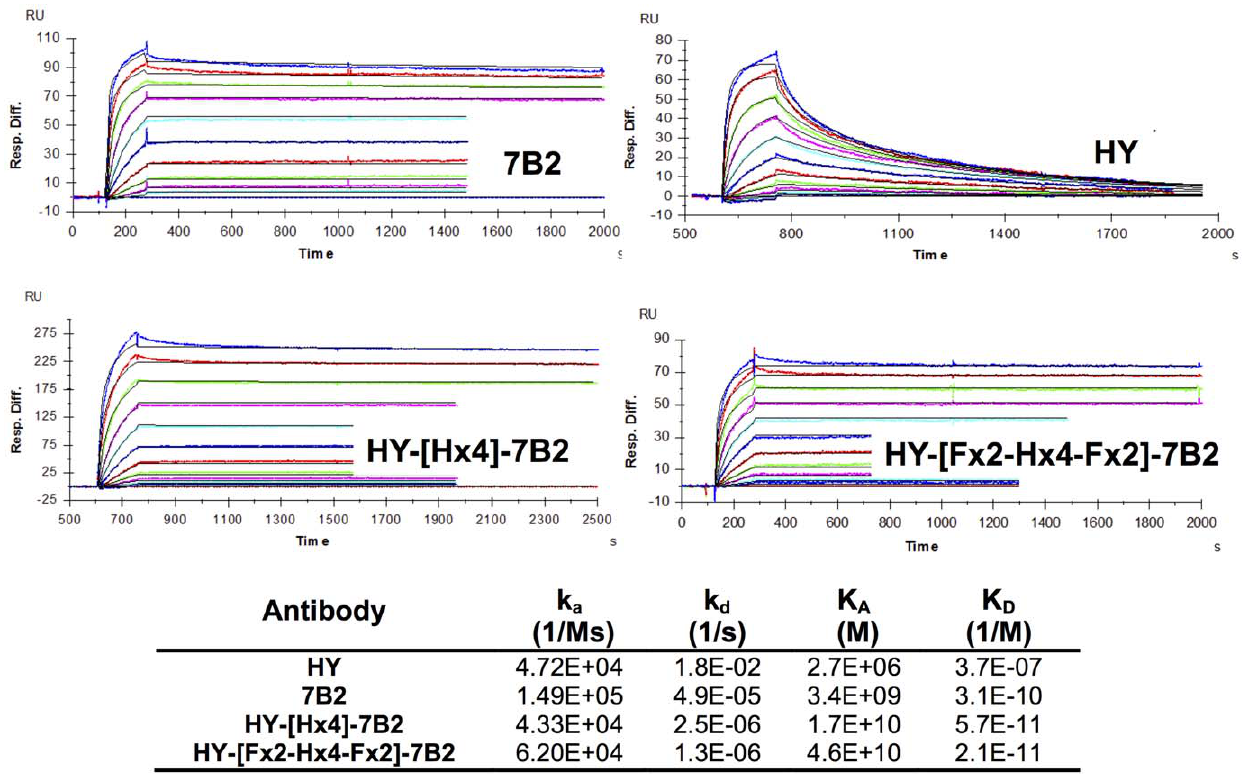
Figure 5. Measurement of binding of DVD-Igs to rgp160 by surface plasmon resonance. Recombinant gp160 was immobilized on sensor chips. Two-fold dilutions of each Ab (400 to 0.39 nM) were run on the chips serially, and Ab desorbed between runs. Ab flowed over the chips for 2.5 min, followed by buffer for 20 min (HY and low concentrations of 7B2 and DVD-Igs) or 60 min (high concentrations of 7B2 and DVD-Igs). The latter parts of the 60 min curves are not shown. Protein bound to the chips (in response units) is shown on the vertical axis, time (sec) on the horizontal. The curves shown are representative of 3–6 replicate runs. Curves fit best to a bivalent analyte binding model for calculation of rate constants.